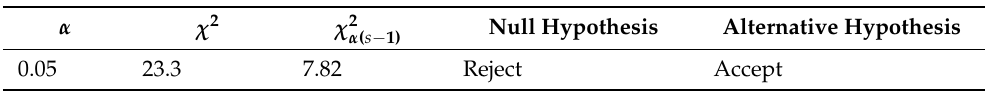
Table 12. The results of the Friedman statistic when the algorithms number s = 4 and standard instances number n = 10.